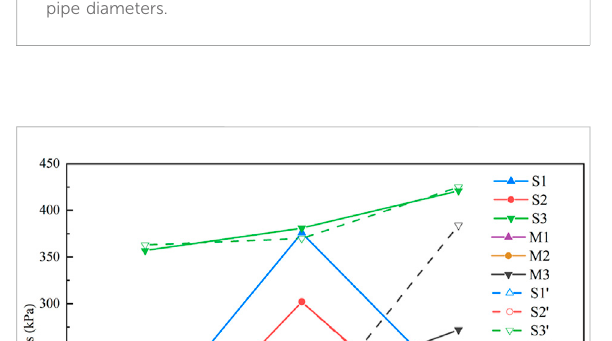
FIGURE 14 Pipeline axial stress of different pipe diameters of section